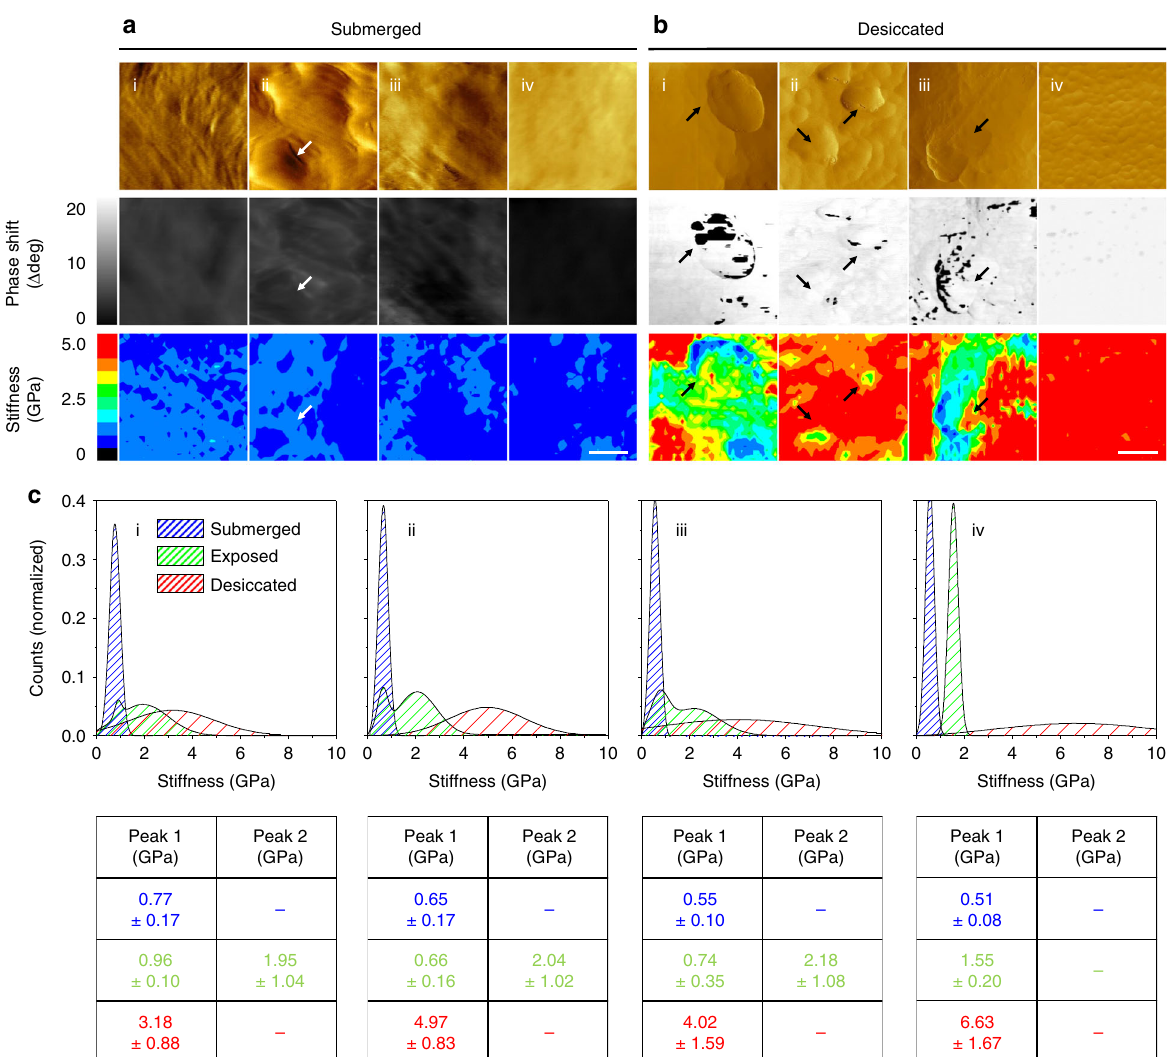
Fig. 4 Hydration effects on cuticle nanomechanics. All panels labeled with (i) represent M. galloprovincialis , (ii) M. californianus , (iii) S. bifurcatus , and (iv) M. capax . a , b AFM amplitude (top row), phase (middle row), and force spectroscopic (lower row, 32 x 32 pixels) images of the submerged ( a ) and desiccated ( b ) cuticles of all species (scale bar = 150 nm). Arrows indicate the granular structures within the individual channels. c Corresponding fi tted stiffness distributions of all force maps (submerged/blue, exposed/green, and desiccated/red, see Supplementary Figure 6 for un fi tted raw datasets), along with the peak values ( n = 576 binned datapoints, mean ± s.d.), are overlaid and